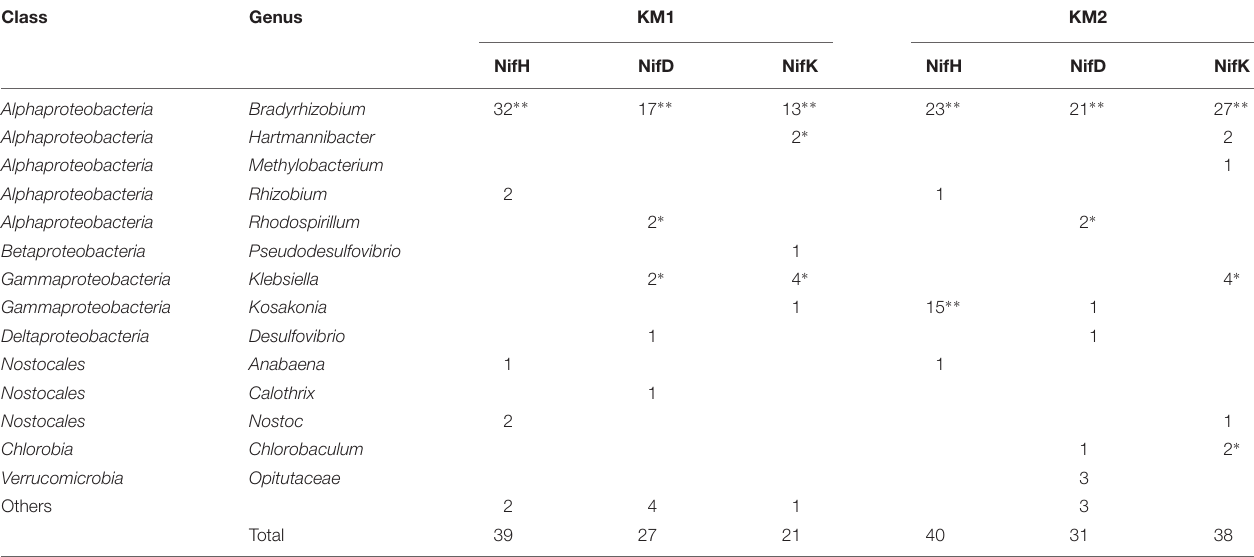
TABLE 4 | Total number of NifHDK peptides in root microbiomes of sorghum lines KM1 and KM2 a .